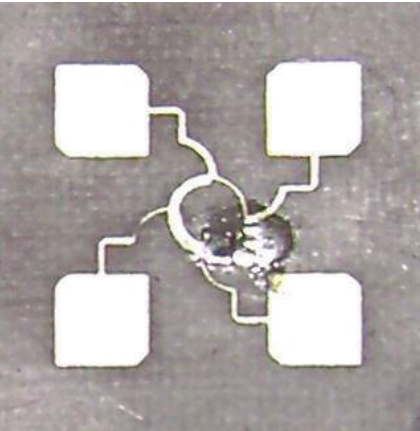
Figure 5: Photograph of 4-element CP antenna array with the proposed single sequential rotation feeding network [11].